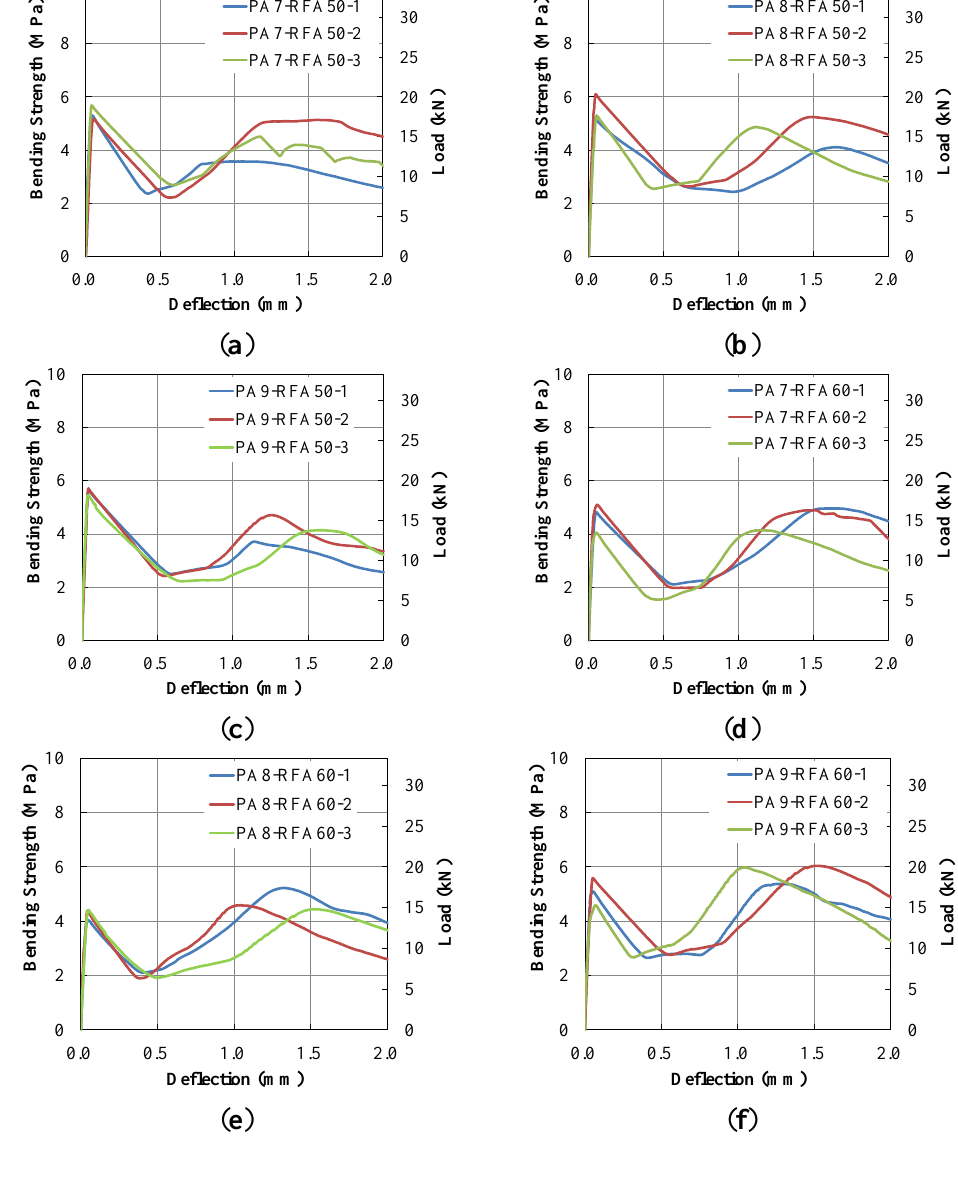
Figure 9. Load-deflection curves. ( a ) PA-7-RFA50; ( b ) PA-8-RFA50; ( c )